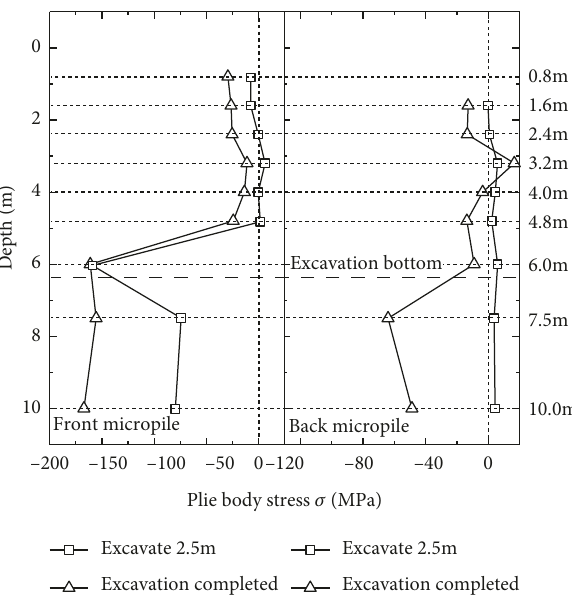
Figure 8: Stress distribution of pile at different excavation